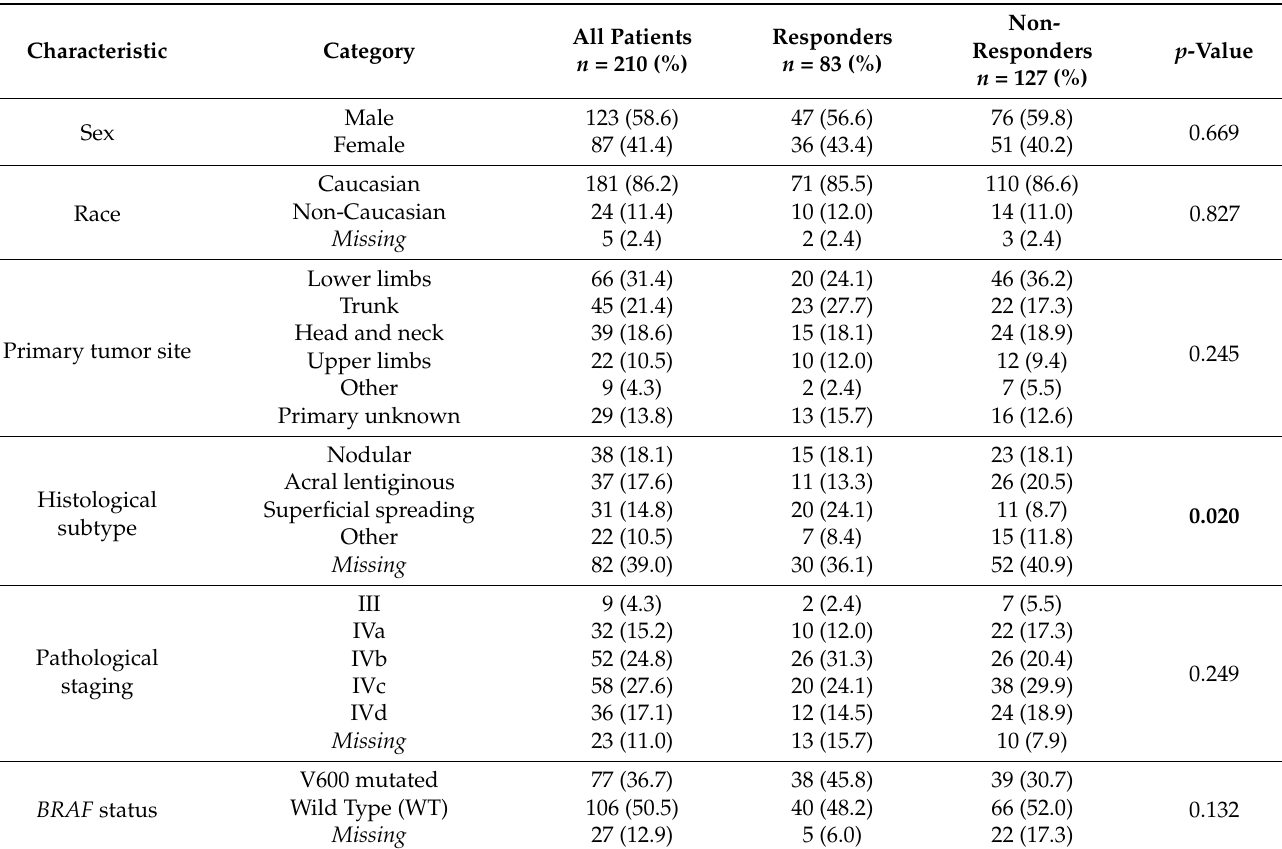
Table 1. Clinicopathological and treatment characteristics of the 210 advanced melanoma patients undergoing immune checkpoint blockade, by patient response